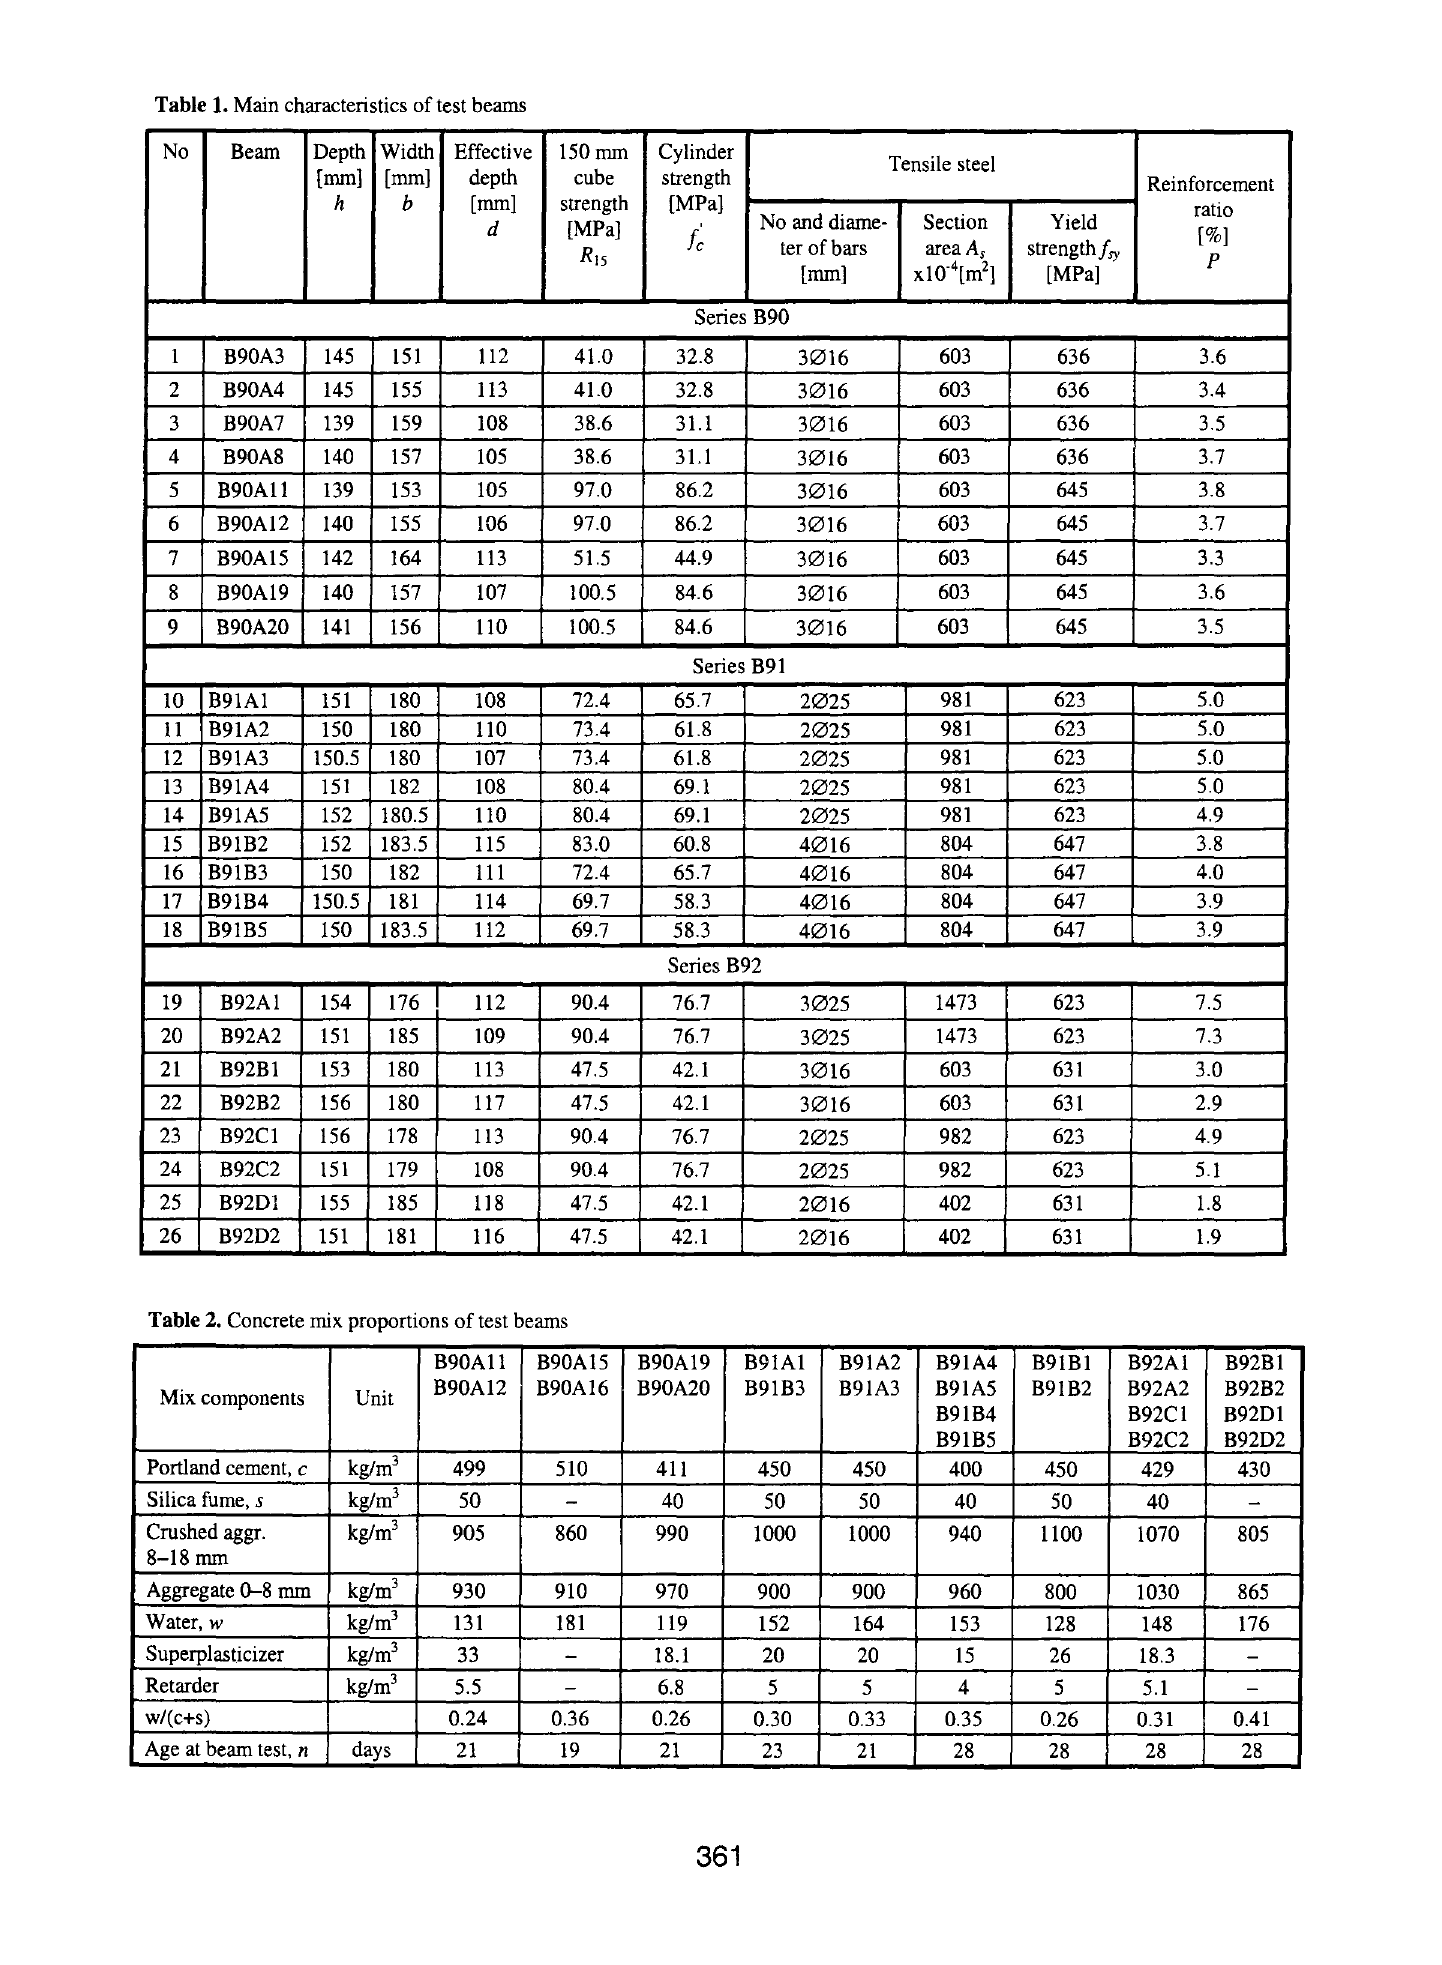
Table 2. Concrete mix proportions of test